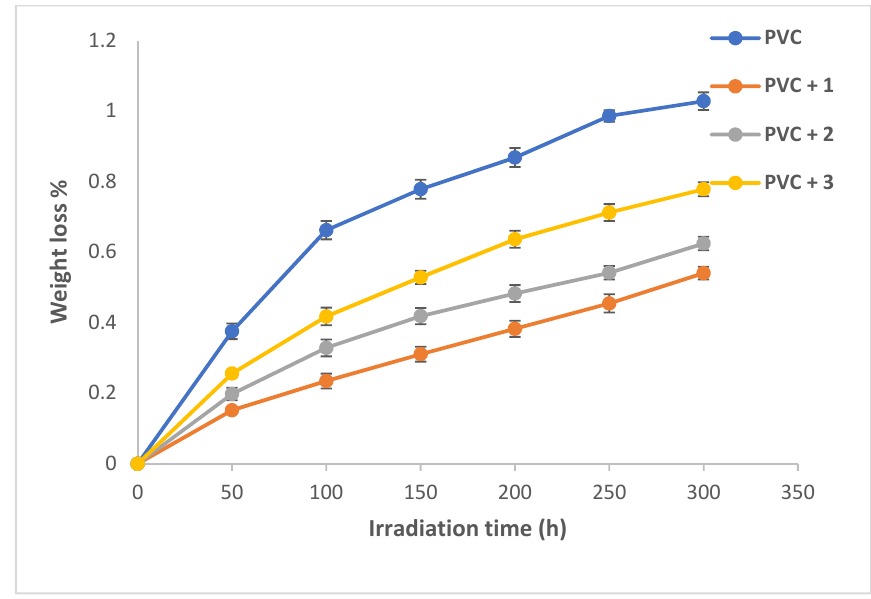
Figure 4. Weight loss of PVC films with irradiation time.